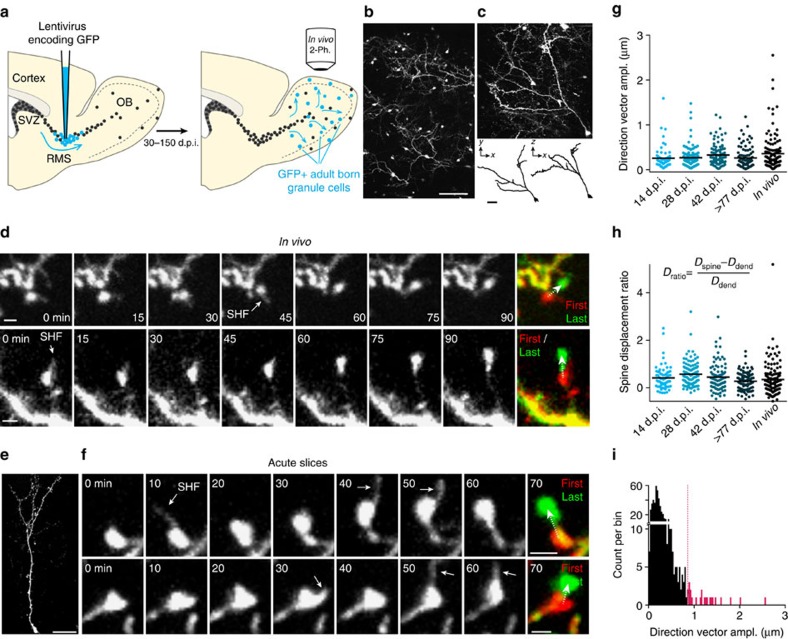
Relocation of mature spines of adult-born GC in the OB.(a) Protocols used for labelling adult-born GC and for in vivo two-photon imaging. Neuronal precursor cells were infected with GFP-expressing lentiviral particles in the rostral migratory stream (RMS). Thirty to 150 days post-injection (d.p.i.), the spines of GFP+ cells were imaged in vivo by two-photon microscopy through a cranial window. SVZ, subventricular zone. (b) Low-magnification projection image of a population of adult-born GC and periglomerular cells taken in vivo. (c) Top—projection image of an isolated adult-born GC. Bottom—lateral view (left) and top view (right) of the reconstructed neuron shown above. (d) Example from two adult-born GC dendrites imaged in vivo at 60–70 d.p.i. showing spine head relocation. The white arrows indicate spine head filopodia (SHF). The first and last z-stacks have been false-coloured in red and green to highlight the extent of spine relocation. (e) Example of an adult-born GC imaged in an acute slice. (f) Sequences of time-lapse two-photon images showing spine relocation on 14 d.p.i. (upper panels) and 42 d.p.i. (lower panels) adult-born GC distal dendrites. (g,h) Ratio of total spine displacement and direction vector amplitude that shows the directionality of spine relocation over 95 min for spines monitored at different maturational stages (n=68, 124, 93, 103 and 126 spines from 7, 7, 7, 5 and 16 mice for the 14, 28, 42, 77 d.p.i. and in vivo conditions, respectively). (i) Histogram showing the direction vector amplitudes for 514 randomly selected spines. Spines with direction vector amplitudes above a z-score value are shown in red. Scale bars, 100 μm, 20 μm and 50 μm for b,c,e, respectively. The scale bar for d,f is 2 μm.